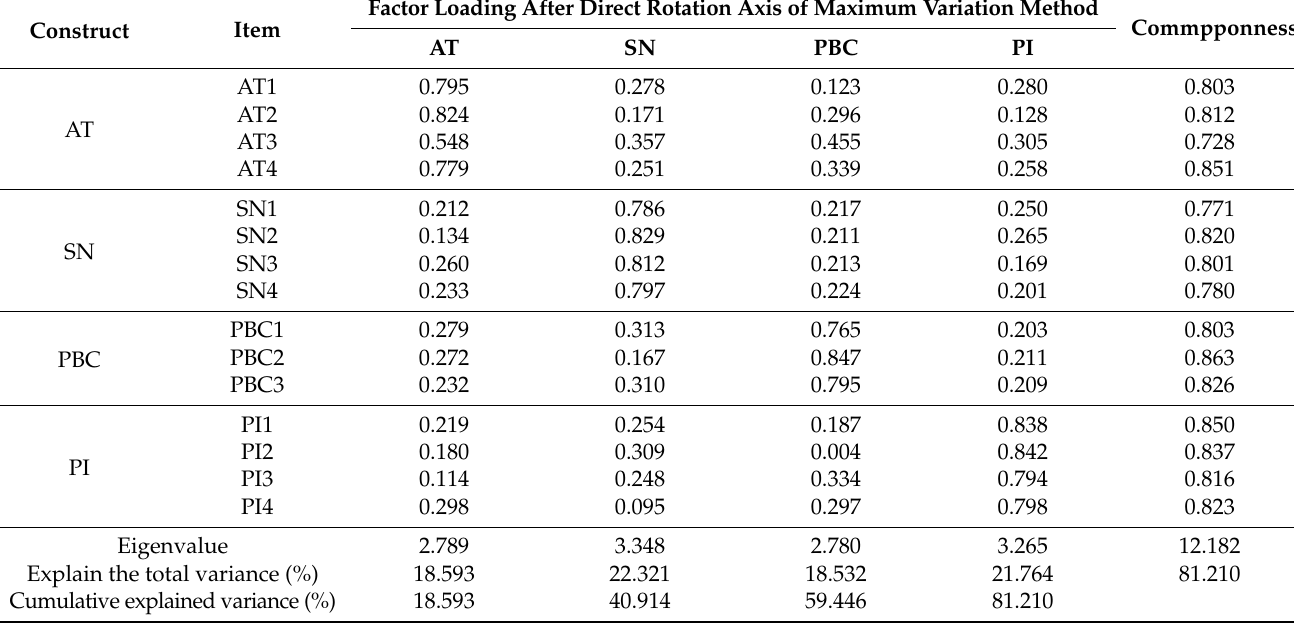
Table A4. Exploratory factor analysis of the pre-survey planned behavior